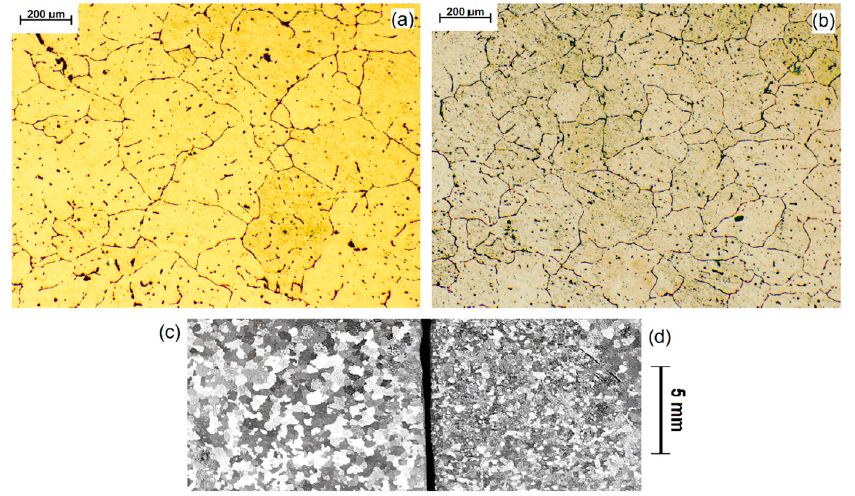
Figure 2. Experiment 1: ( a ) The grain size of untreated metal (208 ± 38 μ m) and ( b ) after treatment (108 ± 19 μ m) decreased by 48%, which is clearly indicated by a macro-scale photograph of a sample taken ( c ) before and ( d ) after ultrasonication.